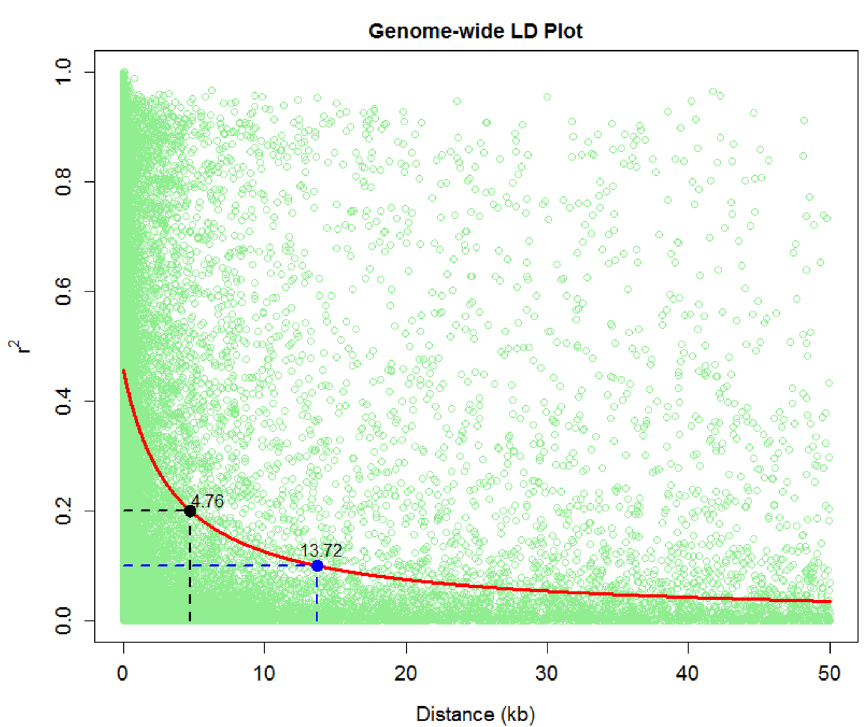
Figure 2. Linkage disequilibrium (LD) decay in the HTAM